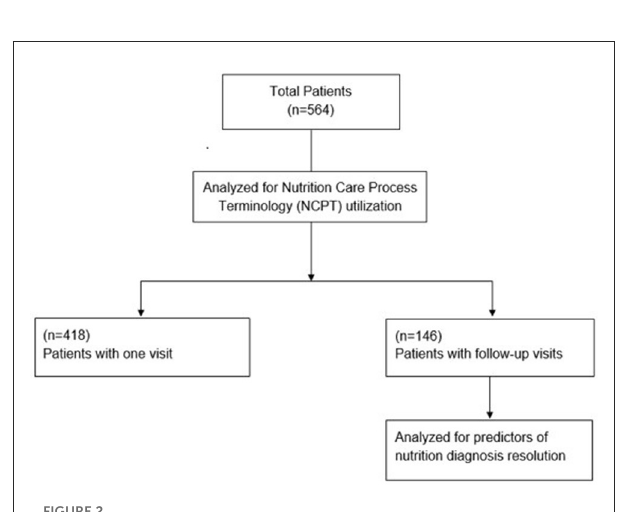
FIGURE2 Data analysis flowchart for patients from the diabetes registry